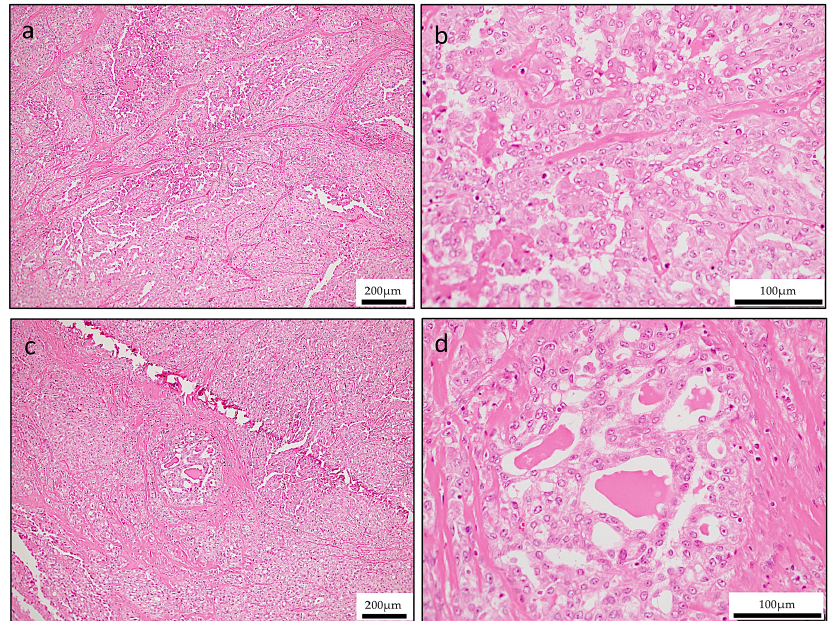
Figure 2. Hematoxylin & Eosin (H&E) staining of tumor revealed various cell populations in primary lesion. ( a , b ) Lobular or papillary growth pattern (a; low-magnification, b; high-magnification. ( c , d ) Solid and follicular growth pattern (c; low-magnification, d; high-magnification). Reports 2020 , 3 , x FOR PEER REVIEW